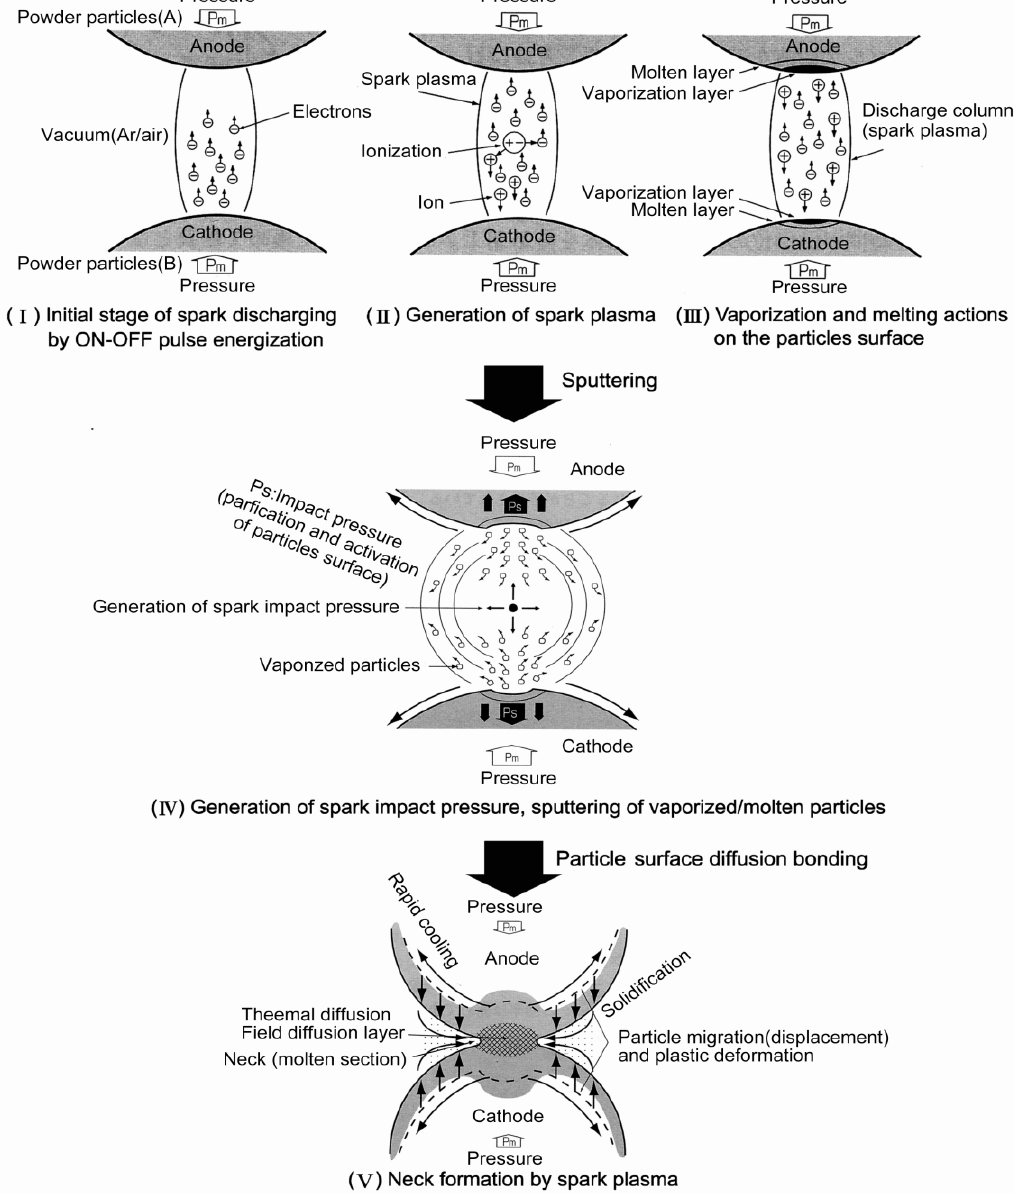
Figure 10. The basic mechanism of neck formation by spark plasma sintering.